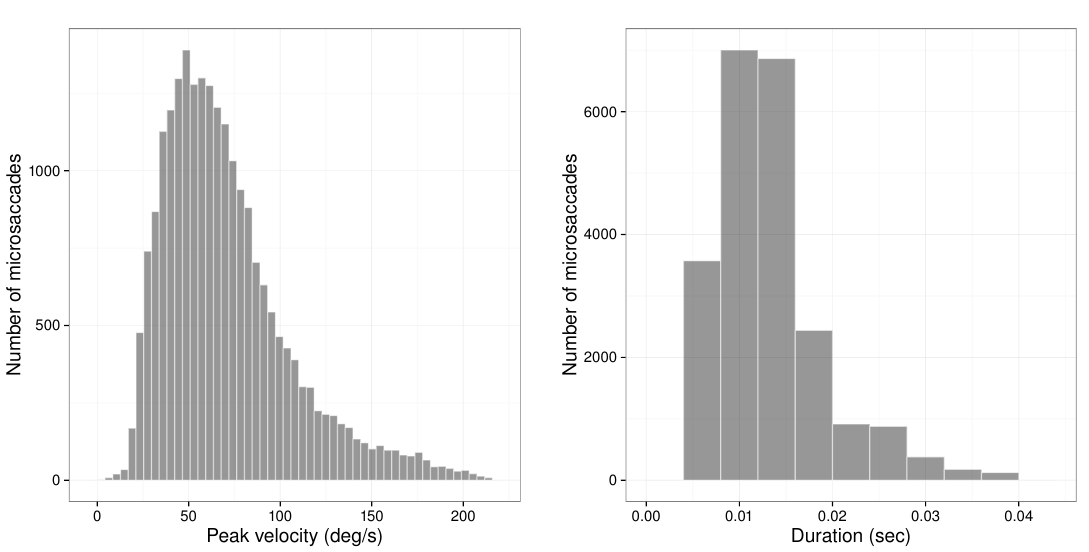
Figure 7 . Experiment 1. Distribution of microsaccade amplitude (b), peak velocity (c), and duration (d). Figure (a) depicts the nonlinear relationship between peak velocity and amplitude with different function fits. Data were captured at 500